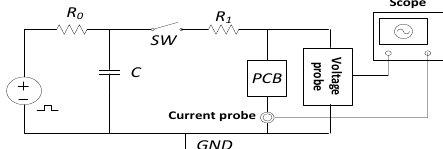
Figure 4. Breakdown test system.